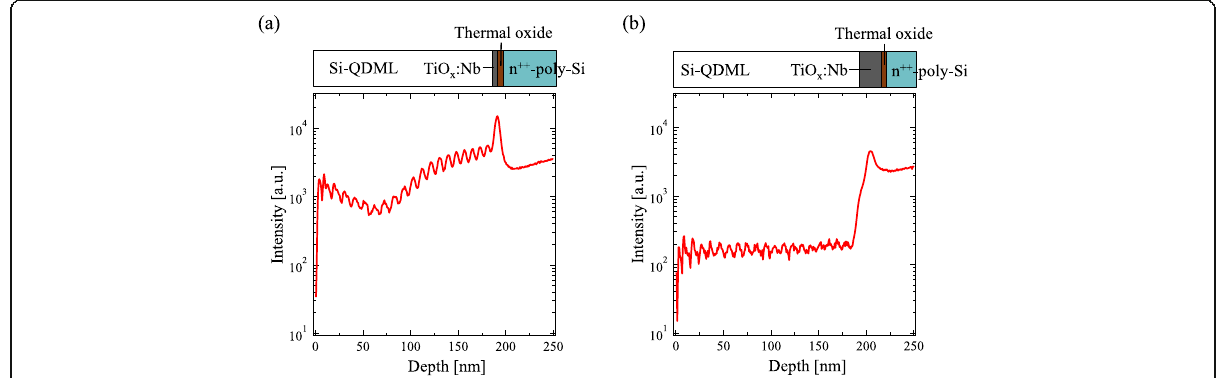
Fig. 3 Depth profile of phosphorus atoms in Si-QDML/TiO x :Nb/thermal oxide/n ++ -poly-Si structure using a 2-nm-thick TiO x :Nb and b 10-nm-thick TiO x :Nb